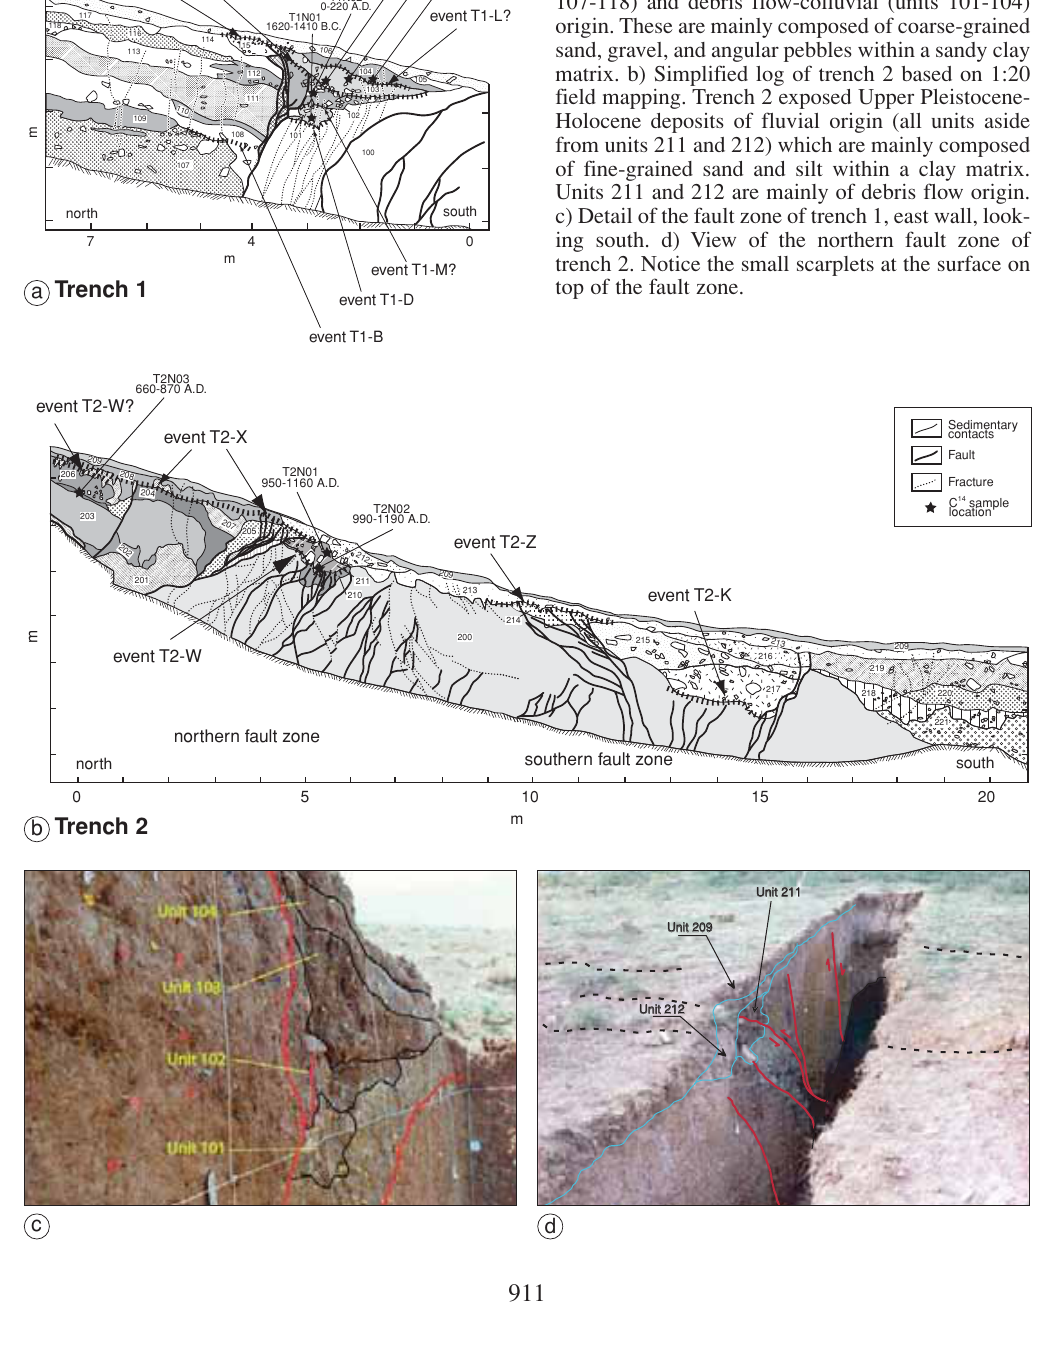
Fig. 7a-d. Trench logs along the North Tabriz Fault west of Tabriz city. a) Simplified log of trench 1 based on 1:20 field mapping. Trench 1 exposed Up- per Pleistocene-Holocene deposits of fluvial (units 107-118) and debris flow-colluvial (units 101-104) origin. These are mainly composed of coarse-grained sand, gravel, and angular pebbles within a sandy clay matrix. b) Simplified log of trench 2 based on 1:20 field mapping. Trench 2 exposed Upper Pleistocene- Holocene deposits of fluvial origin (all units aside from units 211 and 212) which are mainly composed of fine-grained sand and silt within a clay matrix. Units 211 and 212 are mainly of debris flow origin. c) Detail of the fault zone of trench 1, east wall, look- ing south. d) View of the northern fault zone of trench 2. Notice the small scarplets at the surface on top of the fault